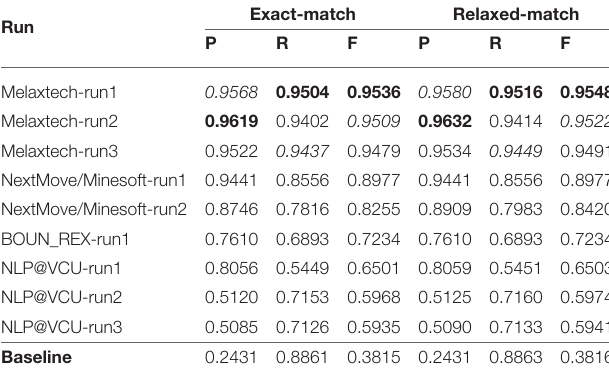
TABLE 8 | Overall performance of all runs in Task 2—Event extraction.